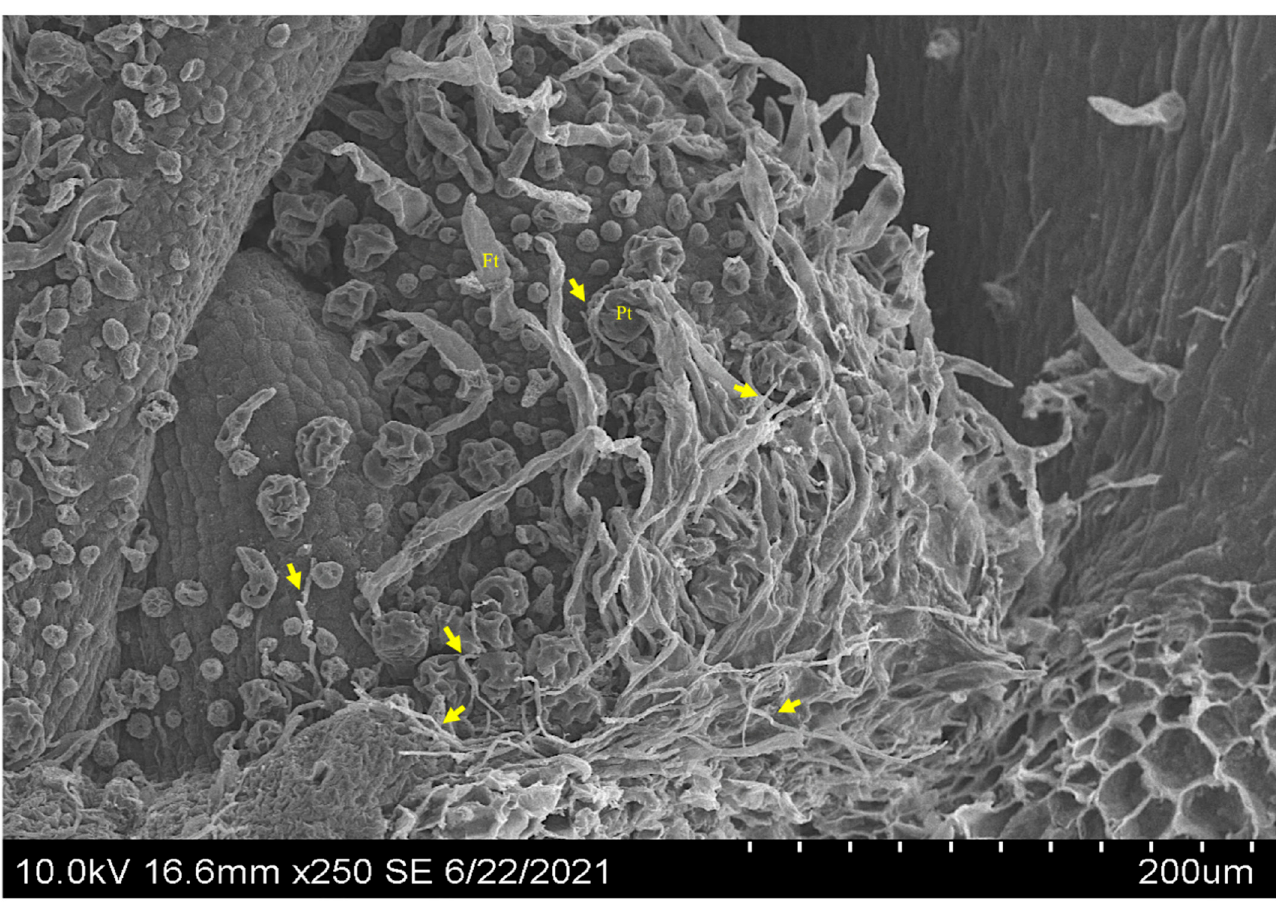
Figure 9. Scanning electron microscope images showing growth of the mycelia in the longitudinal section of the shoot apical meristem (SAM) of a 5-day-old I. carnea positive plant. Arrows point at mycelia in the SAM forming close association with peltate glandular trichomes (Pt) and filiform trichomes (Ft).